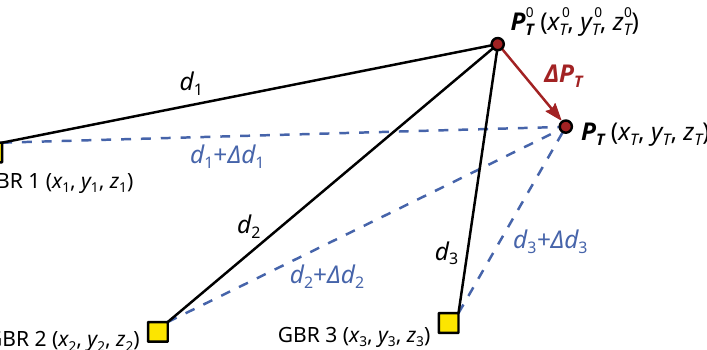
Figure 6. Schema of GBR and target geometry for the transformation of LOS-displacements ∆ d to displacements in a Cartesian coordinate system ∆ p